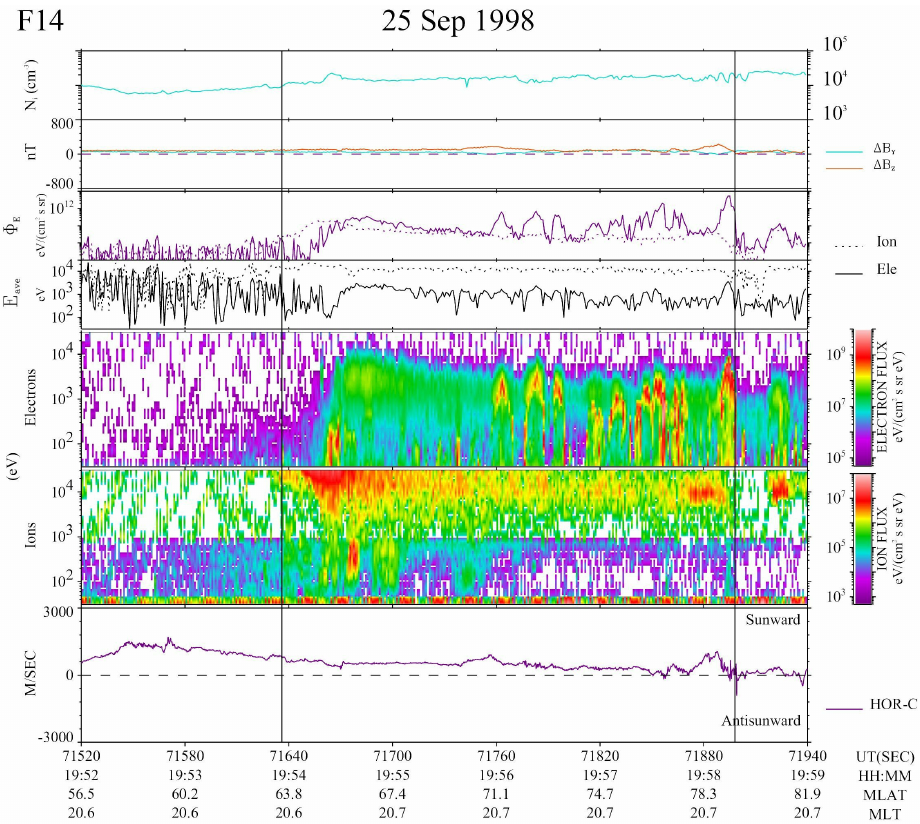
Fig. 14. As Fig. 10, but within the 19:52–19:59 UT interval on 25 September 1998 from the DMSP F14 pass over auroral latitudes.